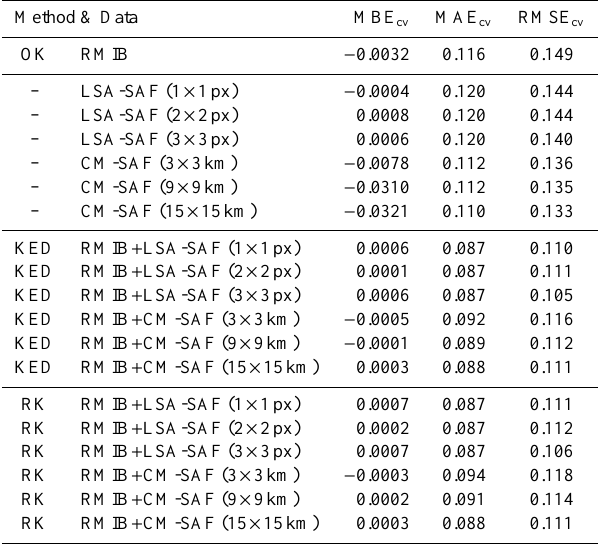
Table 1. Cross validation mean bias error (MBE cv ), mean absolute error (MAE cv ) and root mean square error (RMSE cv ) for the geo- statistical interpolation by OK of the RMIB ground data, the SAFs’ products used at various spatial resolutions, and the geostatistical merging by KED and RK of the RMIB ground data with the SAFs’